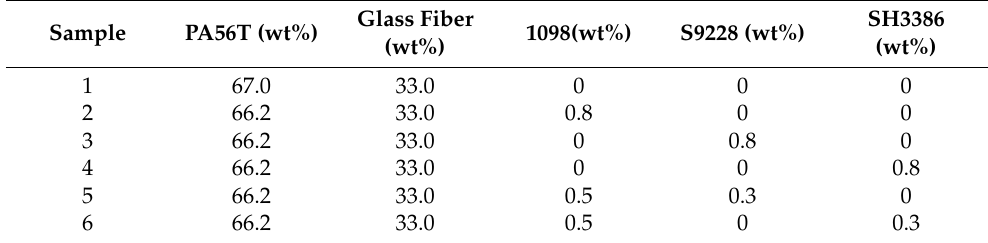
Table 1. The formulas of